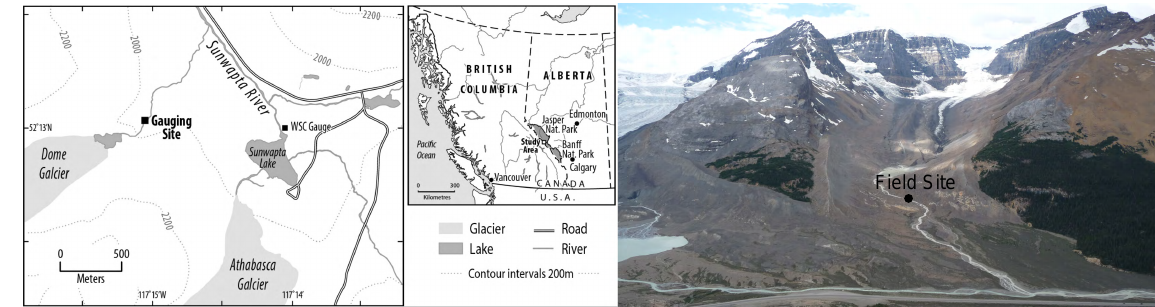
Figure 1. Map of the site location (left) and view of the Dome stream (right); image attribution – J. T. Gardner.